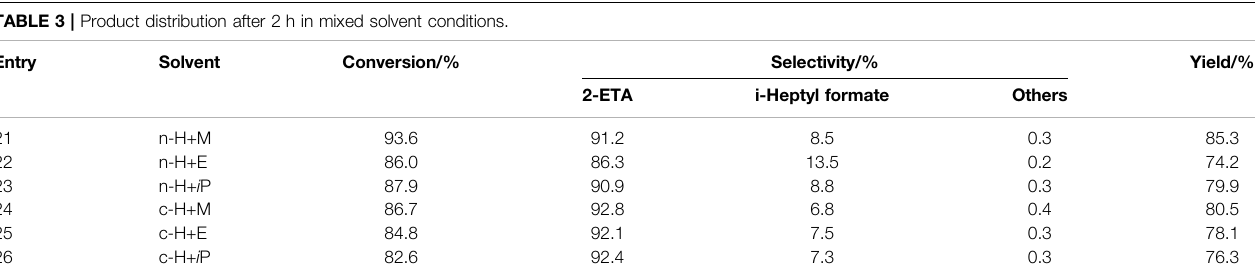
TABLE 3 | Product distribution after 2 h in mixed solvent